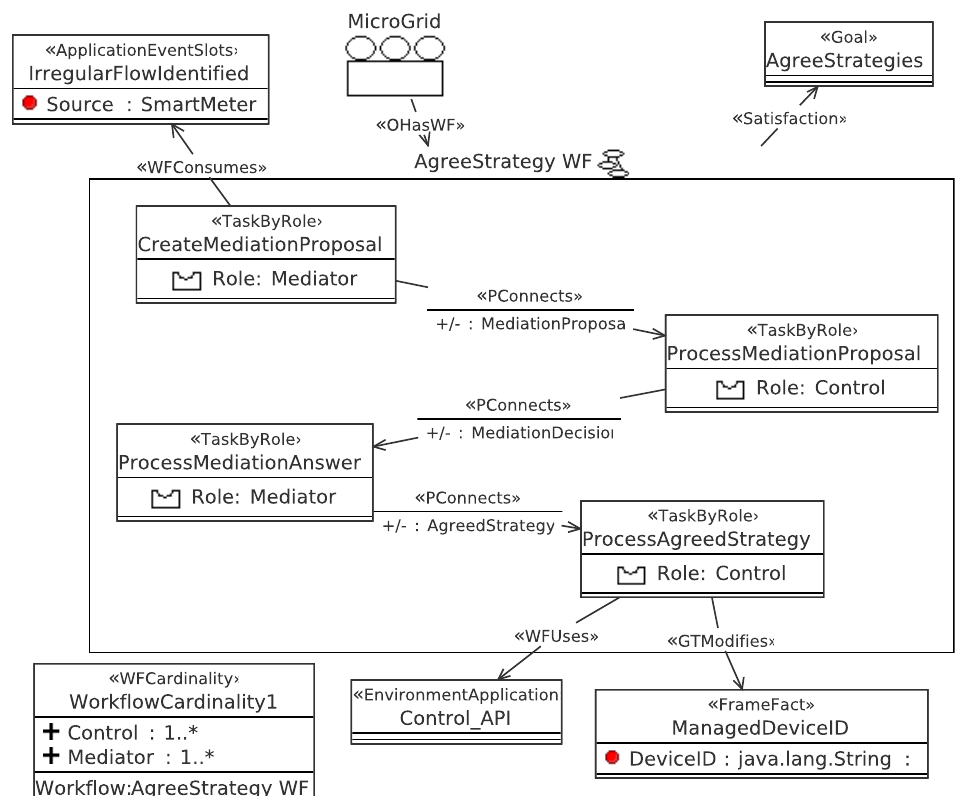
Figure 11. New workflow for arranging agreements among control